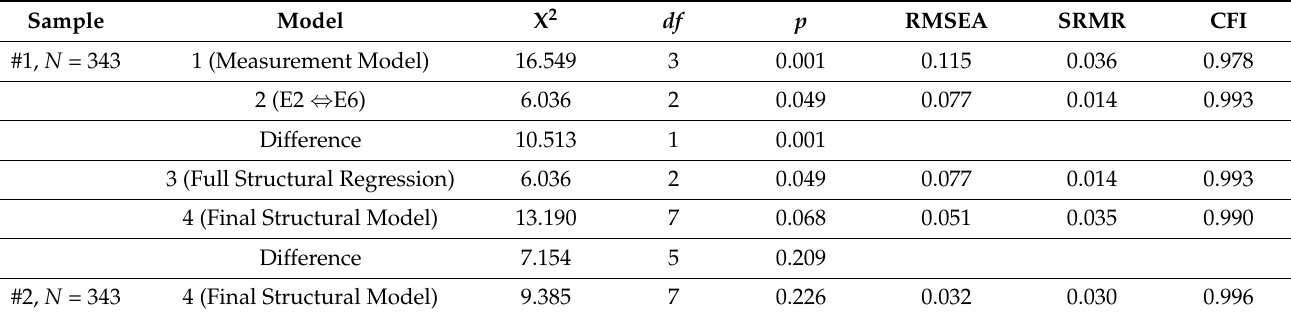
Table 4. (Study 2: Fiji) . Fit Indices for Measurement and Structural Regression